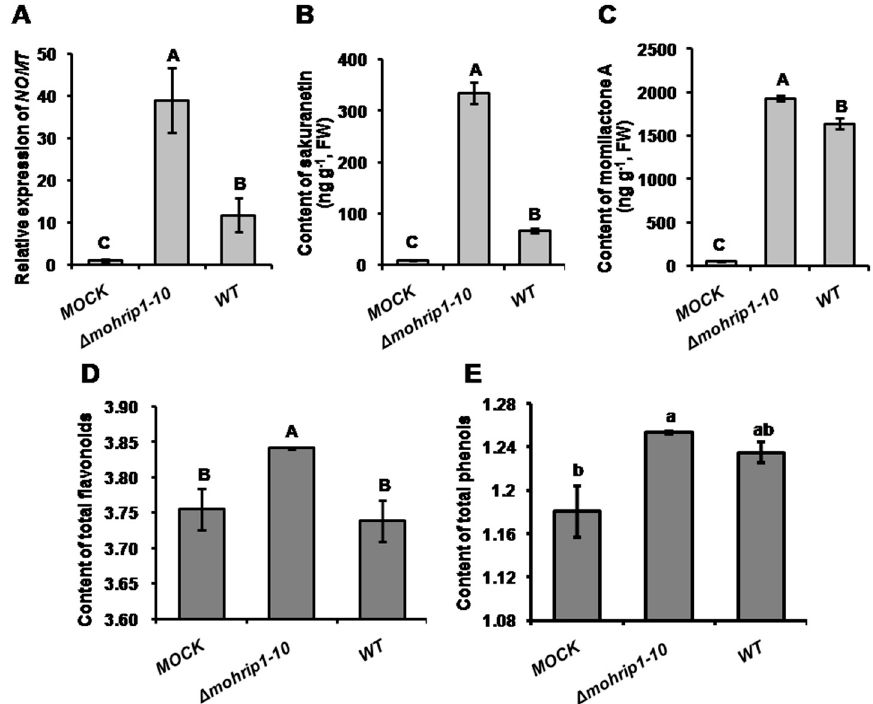
Figure 7. MoHrip1 inhibits the production of defensive compounds. ( A ) Improved transcription of OsNOMT by the treatment with ∆ mohrip1-10 at 3 dpi. OsNOMT encodes naringenin 7- O -methyltransferase critical for the biosynthesis of sakuranetin, the only known flavonoid phytoalexin in rice to date. ( B ) Contents of sakuranetin measured by HPLC-MS/MS. ( C ) Contents of momilactone A measured by HPLC-MS/MS. ( D ) Contents of total flavonoids measured by spectrophotometer. ( E ) Contents of total phenols measured by spectrophotometer. The contents of total flavonoids and phenols were respectively indicated by the absorbance values at OD 280 nm (for total phenols) and OD 325 nm (for total flavonoids). The bioassay conducted three times independently, each time with three repeats. Error bars represent SD. The “a”, “b” and “A”, “B”, “C” respectively represent the significance analyzed using Duncan’s multiple range test at p < 0.05 and p < 0.01. MOCK, ∆ mohrip1-10 , and WT respectively represent the rice seedlings treated with 0.2% Tween 20, mohrip1 deletion mutant and the wild type strain.